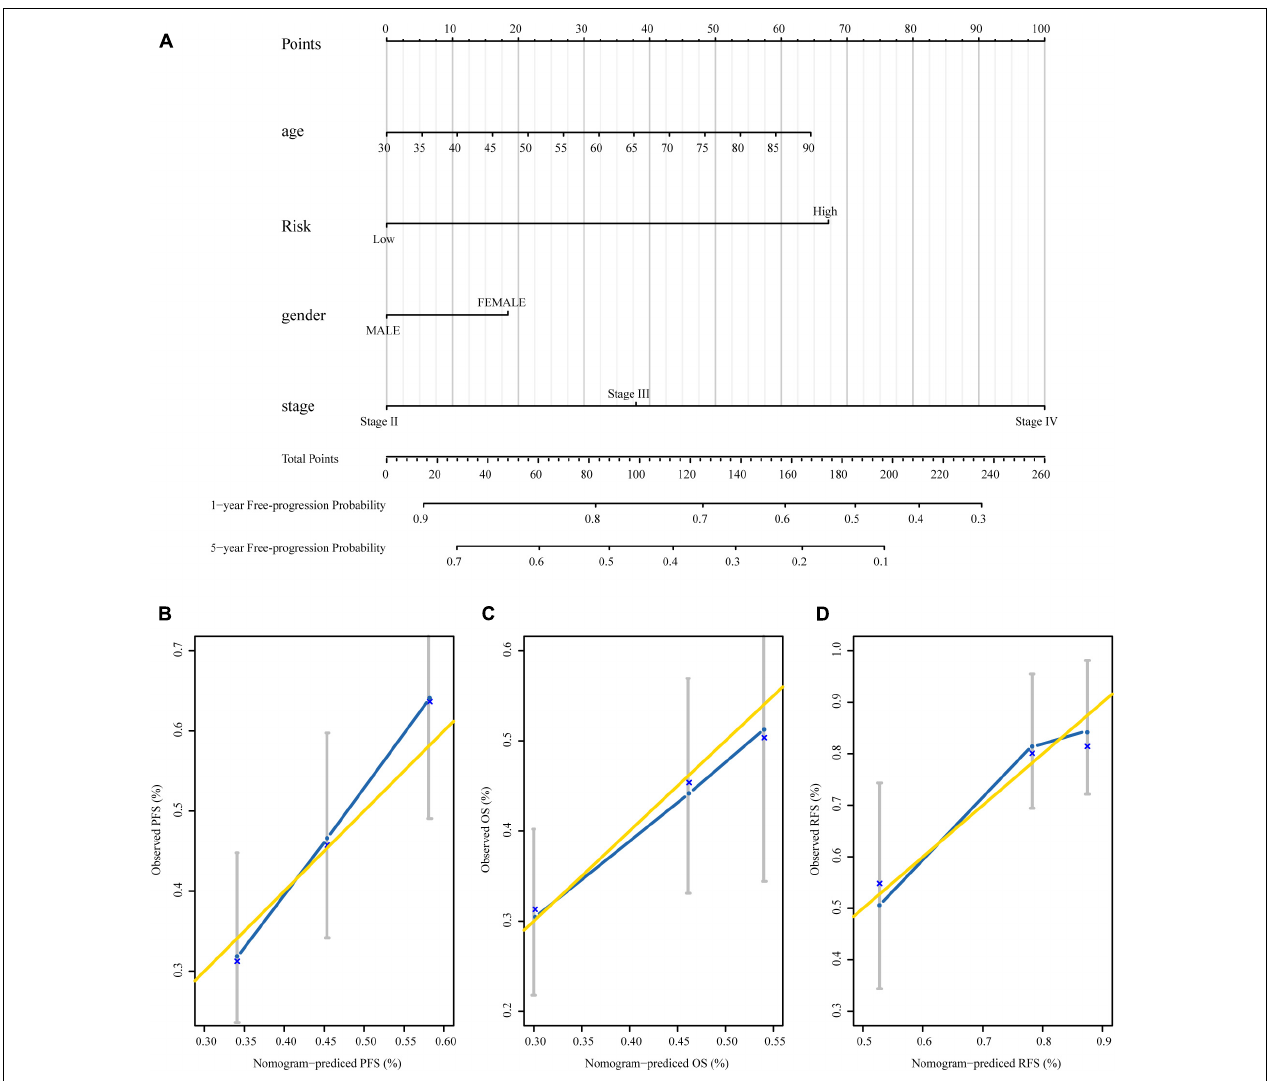
FIGURE 6 | The nomograms based on MRSB are reliable predictors for the prognosis of BLCA patients. (A) Nomogram to predict the 1- and 5-year PFS. (B) Calibration curve for the PFS nomogram model in the TCGA BLCA cohort. (C) Calibration curve for the OS nomogram. (D) Calibration curve for the RFS nomogram model. The gold line represents the ideal nomogram, and the blue line represents the observed nomogram (for the OS and RFS nomogram see the Supplementary Material ). MRSB, methylation risk score for bladder cancer; BLCA, Bladder cancer; PFS, progression-free survival; TCGA, The Cancer Genome Atlas; OS, overall survival; RFS, recurrence-free